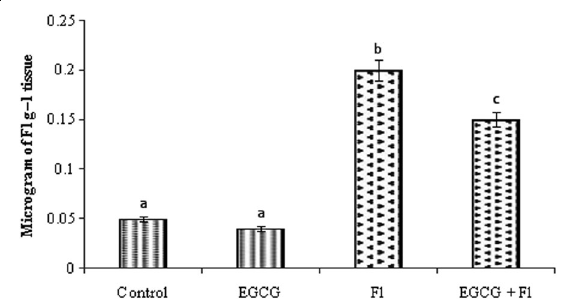
Fig. 3 Effect of EGCG on the concentration of Fl in the brain of the control and experimental rats. Values are mean ± SD for 6 rats in each group. Values not sharing a common superscript letter (a, b, and c) differ significantly at p < 0.05